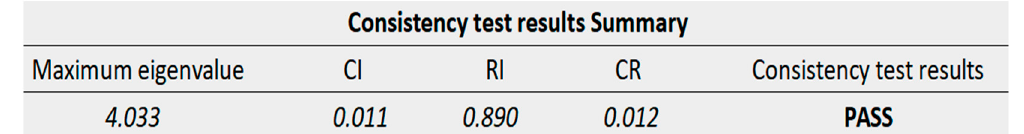
Figure 5. Multi-level weight graph.